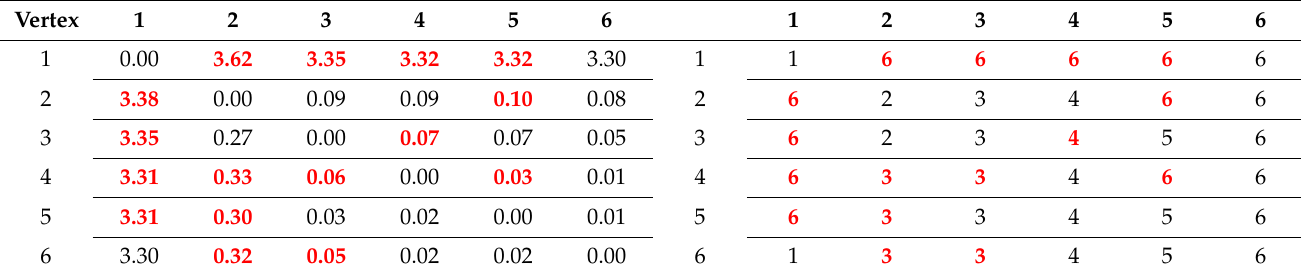
Table 7. The best search and rescue route calculation matrix.